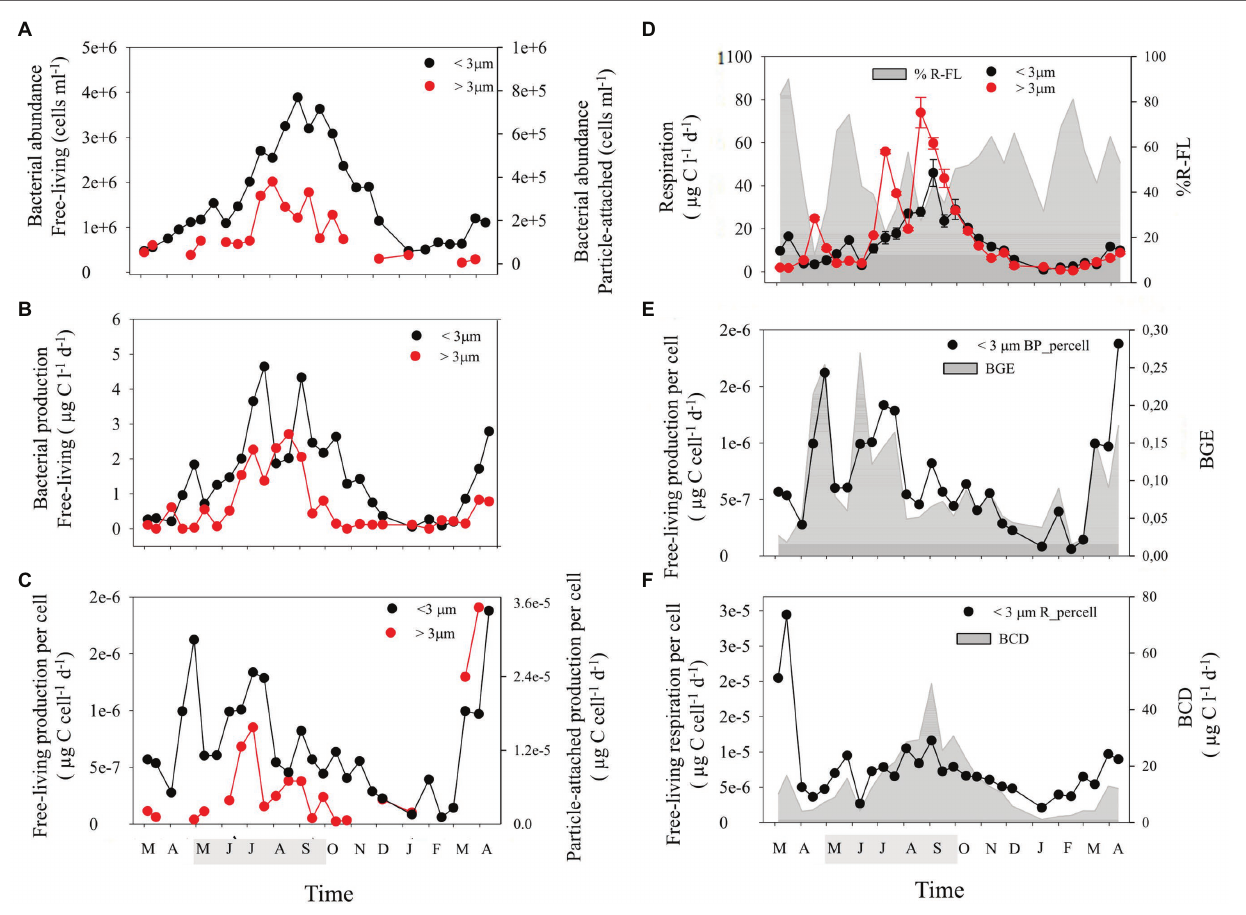
FIGURE 2 | Temporal evolution of: (A) abundance of FL and PA bacteria, (B) heterotrophic bacterial production in FL and PA size-fractions, (C) production per cell in FL and PA bacteria, (D) respiration in FL and PA bacteria and contribution of FL bacteria to total respiration (%R-FL, gray shading), (E) bacterial production per cell and bacterial growth efficiency (BGE) in FL bacteria, and (F) bacterial respiration per cell and bacterial carbon demand (BCD) in FL bacteria. Note the different scales on additional y-axes in panels A , C , D , E , and F . Data for the FL and PA size-fractions are indicated by <3 μ m and >3 μ m, respectively. The shaded period in the x-axis corresponds to